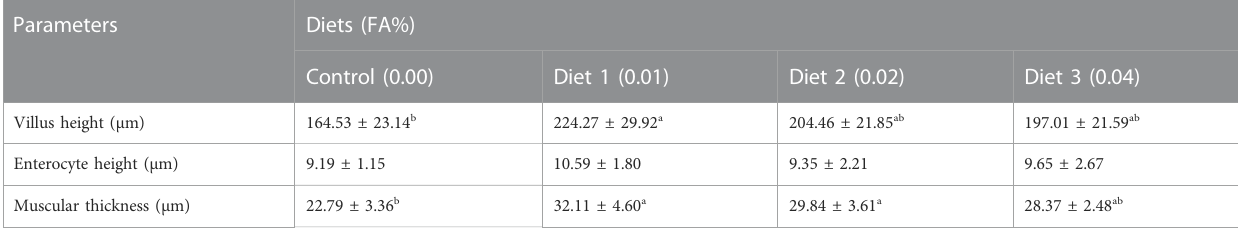
TABLE 5 Effects of supplemental fulvic acid on micromorphology of the intestine of large yellow croaker larvae (Means ± S.E.M., n = 3) 1 .